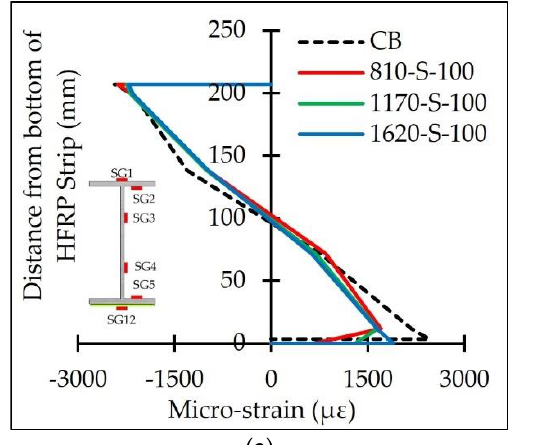
Figure 26. Strain distribution along the HFRP strips of 810-S-100, 1170-S-100 and 1620-S-100 at 380 kN. 3.3.4. Effect of HFRP Thickness Figure 27 displays the strain profiles at the mid-segment sections of 1620-S-45 and 1620-D-45 specimens at a load of 310 kN. Both beams are strengthened with 1620 mm long HFRP strips using bolts spaced at 45 mm. The tensile strains at the mid-segment of 1620- S-45 showed close values to those measured in 1620-D-45. This observation highlights the insignificant effect of doubling the thickness of HFRP strips (1620-D-45) on the strain com- patibility of the fastened components. This could be attributed to the fact that bearing was not the dominating failure mode for all tested specimens; therefore, increasing the bearing